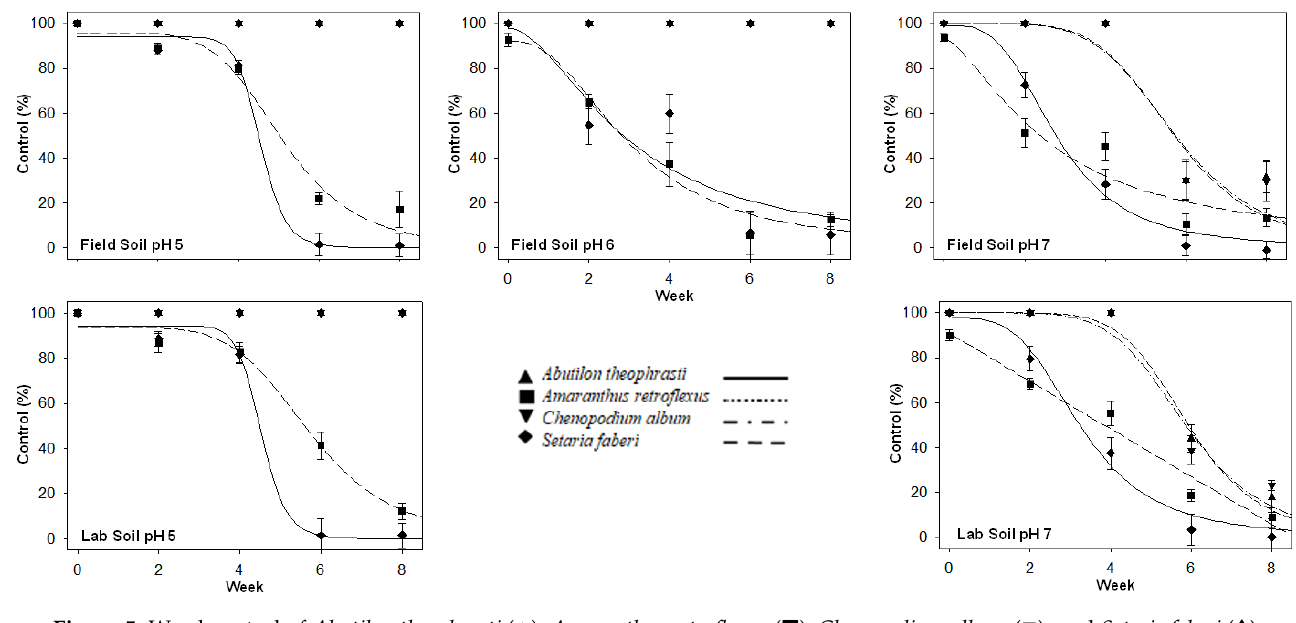
Figure 5. Weed control of Abutilon theophrasti ( ▲ ), Amaranthus retroflexus ( ■ ), Chenopodium album ( ▼ ), and Setaria faberi ( ♦ ) with flumioxazin as affected by soil pH over time for lab and field soils. Fitted lines for expected control are calculated by linear ( y = a + bx ) or logistic regression ( y = a /(1 + ( x / b )^ c )) for Abutilon theophrasti , Amaranthus retroflexus , Chenopodium album , and Setaria faberi . Error bars represent the standard deviation of the mean.